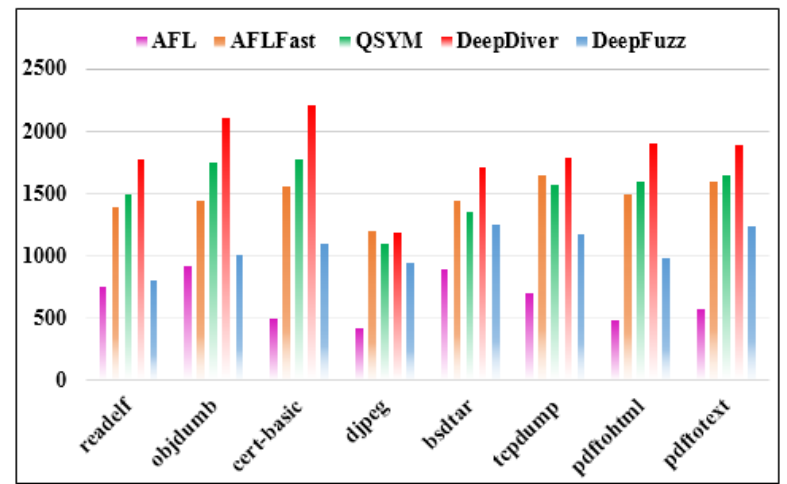
Figure 6. Execution speed evaluation on the real-world programs (from 0 to 2500 executions per